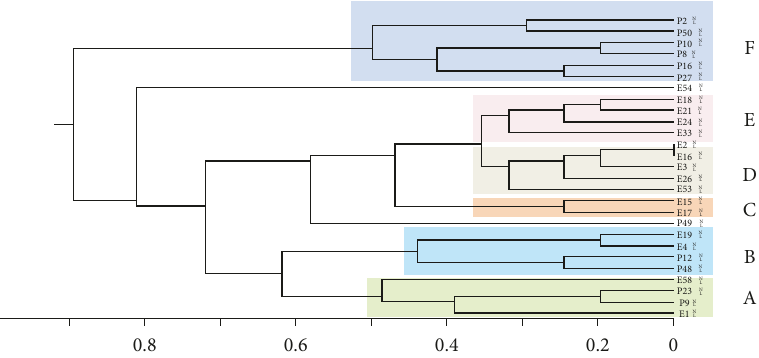
Figure 5: ERIC pattern of A. baumannii from environment isolates.